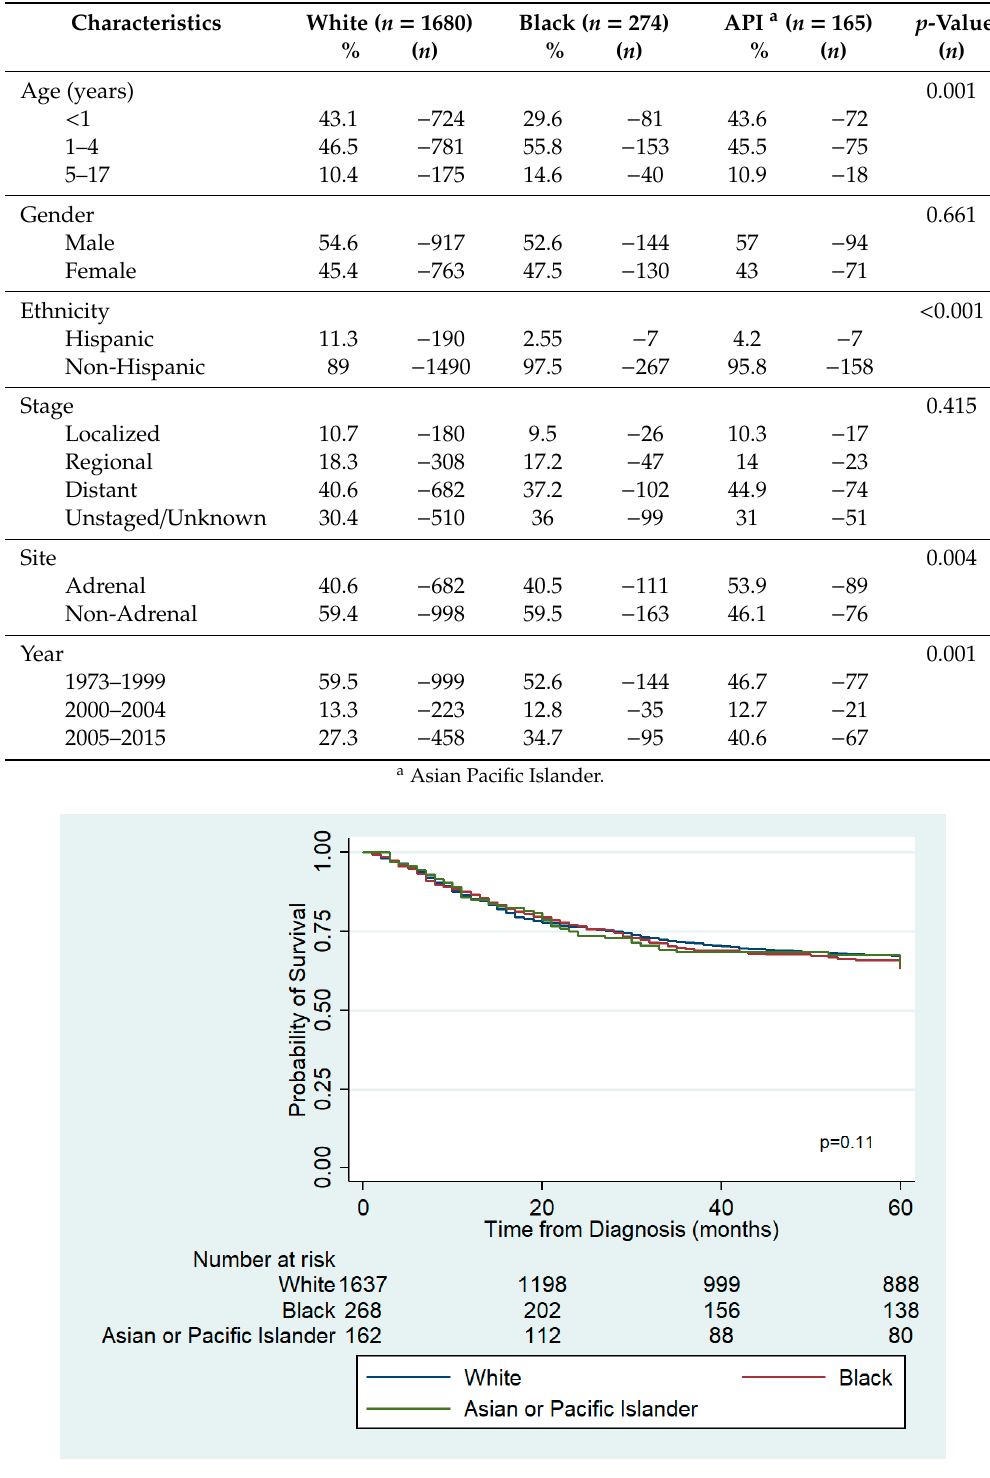
Figure 1. Adjusted survival curves according to race for patients in the SEER database diagnosed with neuroblastoma,